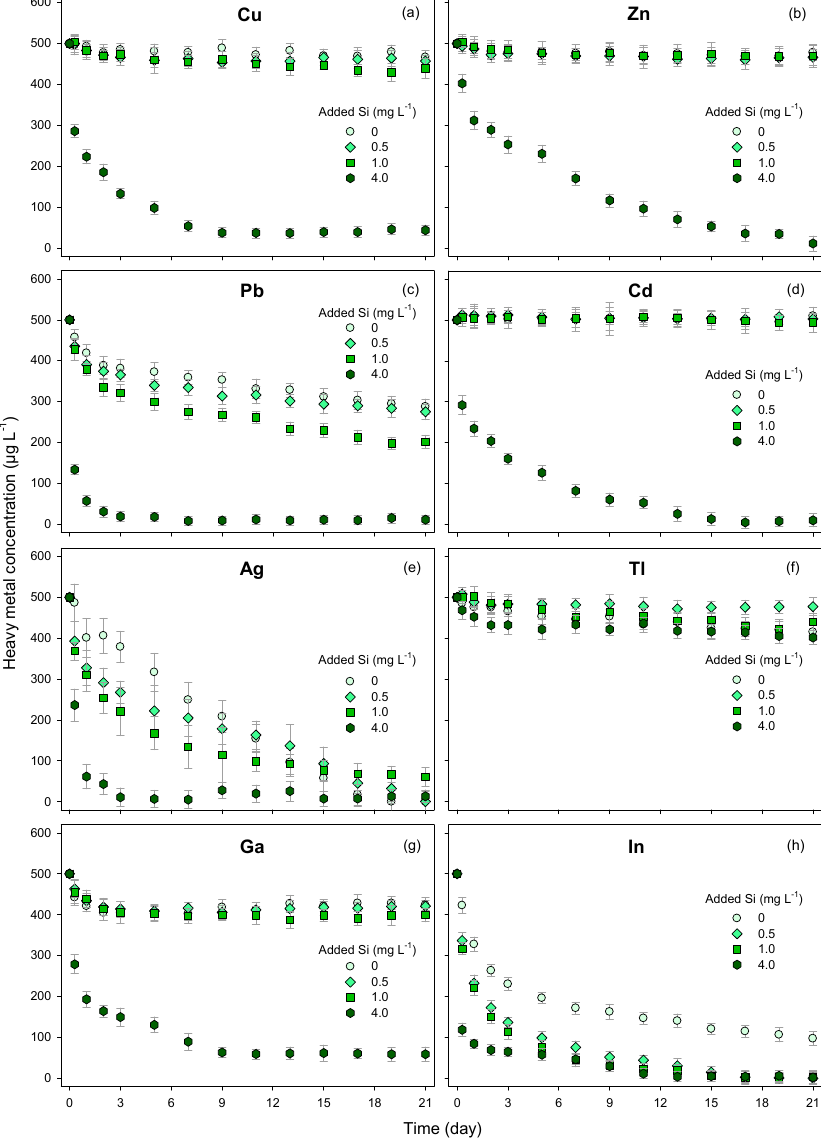
Figure 1. Removal e ffi ciencies of Cu ( a ), Zn ( b ), Pb ( c ), Cd ( d ), Ag ( e ), Tl ( f ), Ga ( g ), and In ( h ) from aqueous solutions by E. acicularis as functions of time and dissolved Si concentration.